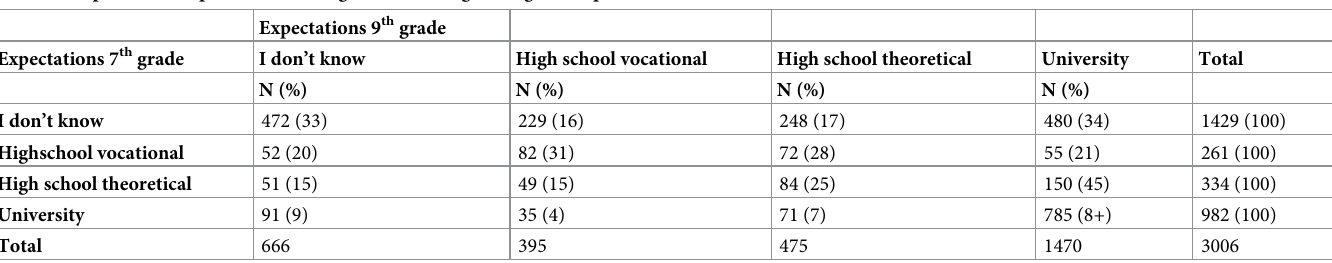
Table 1. Expectations reported in the 9 th grade according to 7 th grade expectations.